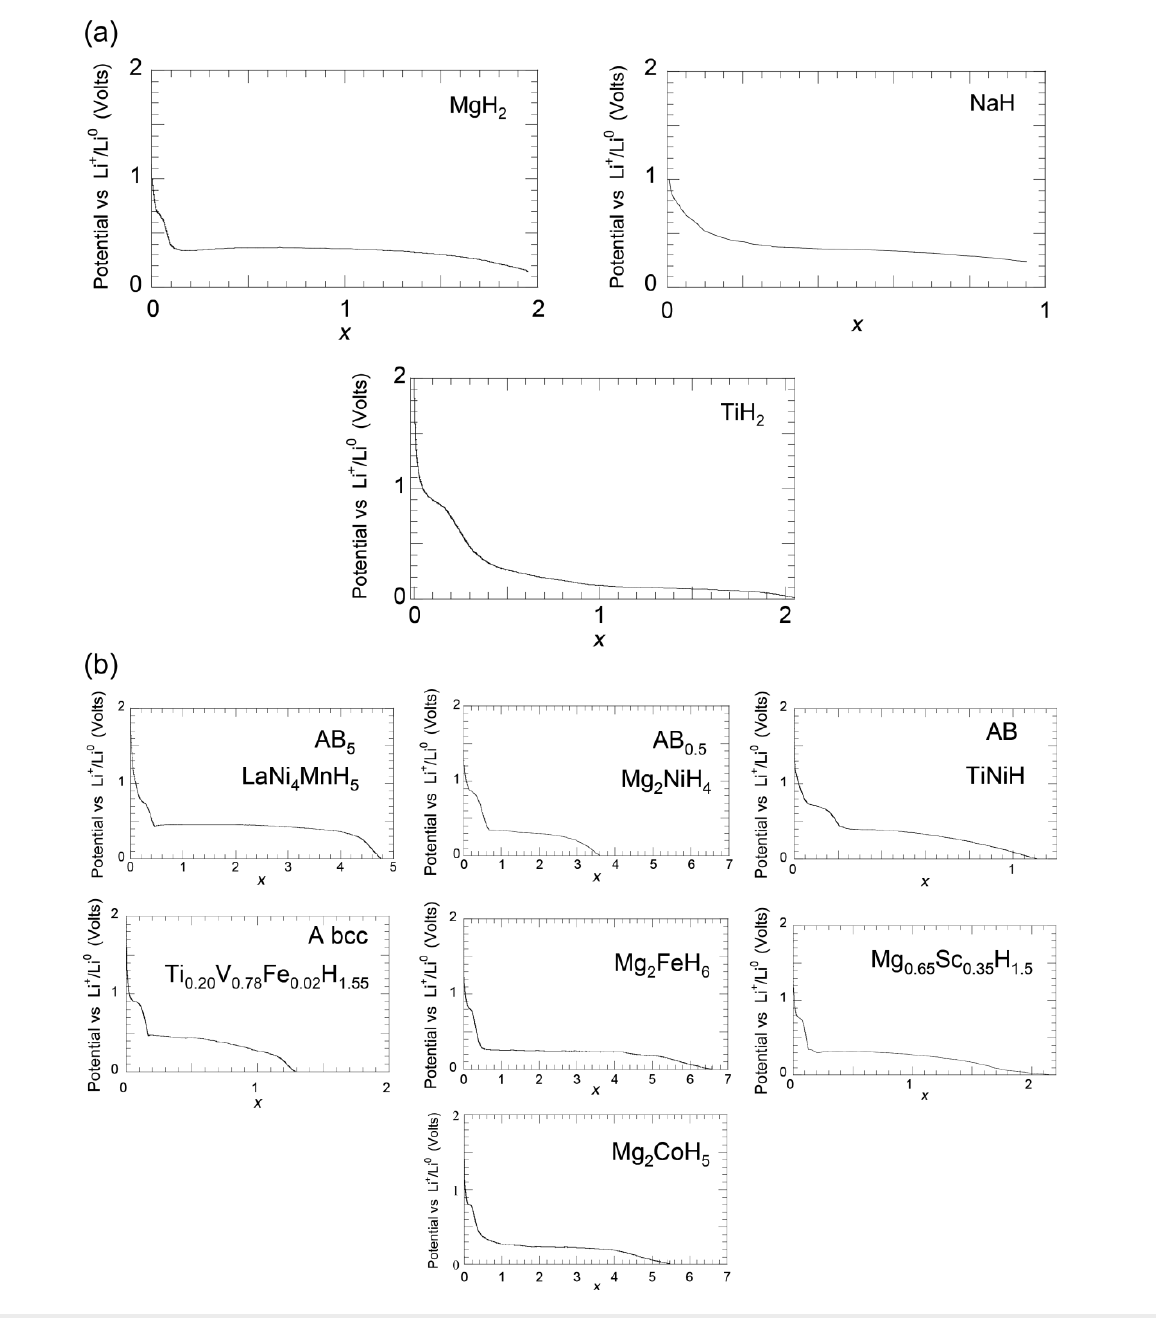
Figure 3: Potentials vs Li + /Li 0 of MH x /Li cells (V) as a function of the mole fraction of Li ( x ) recorded between 3 and 0.005 V; (a) MgH 2, NaH and TiH 2 , (b) LaNi 4 MnH 5, Ti 0 . 20 V 0.78 Fe 0.02 H 1.55, Mg 2 NiH 4 , Mg 2 FeH 6, Mg 2 CoH 5, TiNiH, and Mg 0.65 Sc 0.35 H 2.25 [11,79].